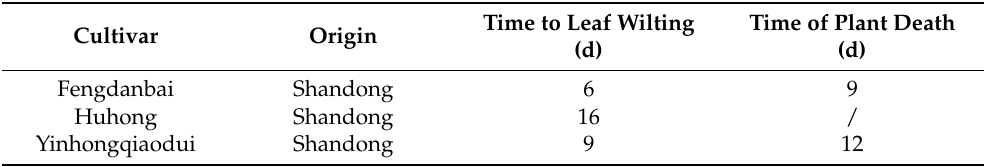
Table 1. Time to onset of l.eaf wilting and plant death in ‘Fengdanbai’ ‘Yinhongqiaodui’ and ‘Huhong’ cultivars of peony under high-temperature